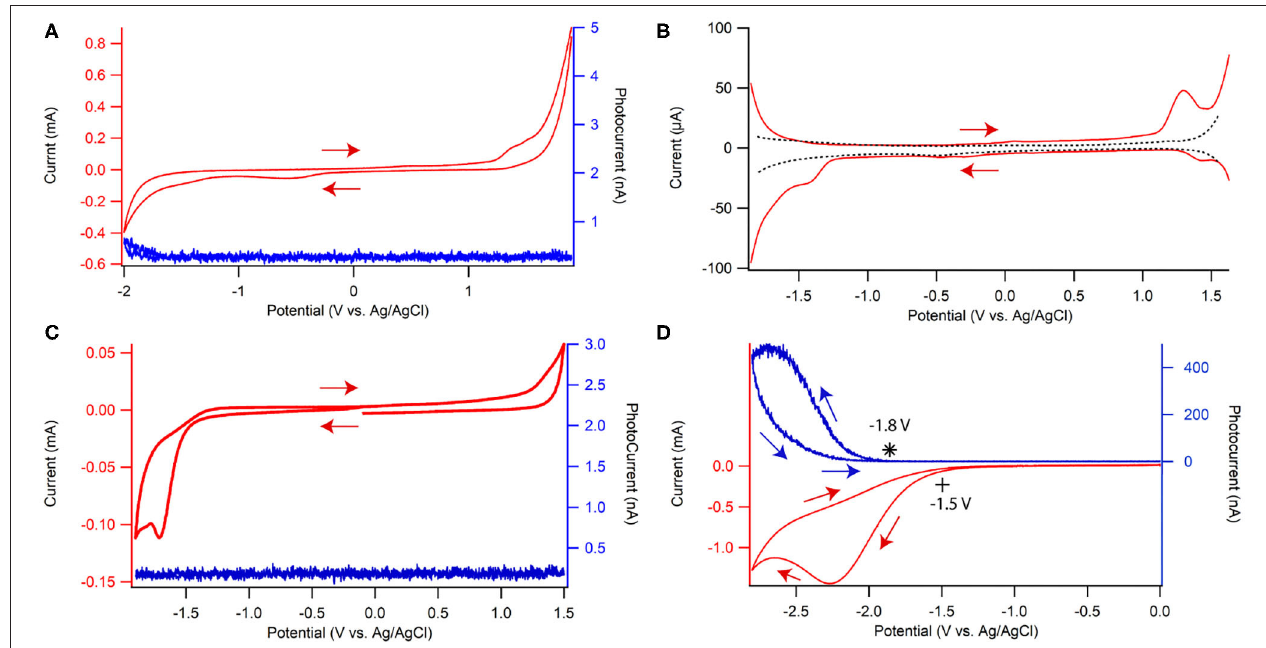
FIGURE 4 | (A) Cyclic voltammogram ECL-voltage curve and (B) differential pulse voltammograms of 0.1 g/L CQD10 in 0.1M phosphate buffer solution at pH of 7.5 with 0.1M KCl as the supporting electrolyte. Cyclic voltammograms (red) and ECL-voltage curves (blue) of a CQD-modified glassy carbon electrode in the same solution without (C) and with (D) 100mM K 2 S 2 O 8 , where * denotes the onset of photocurrent during the ECL-Voltage curve. ECL intensity is represented by the photocurrent measured with a photomultiplier tube biased at − 750V.